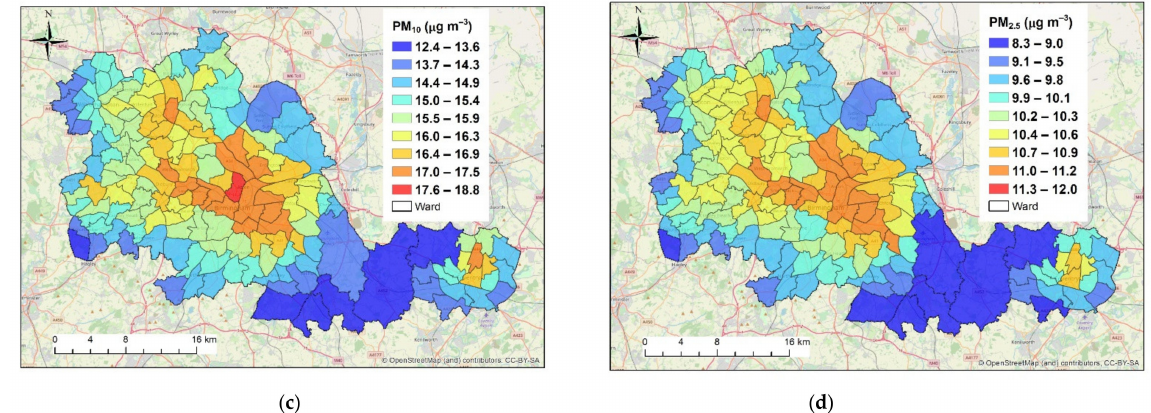
Figure A3. Projected annual air quality maps for ( a ) NO x (in µ g m − 3 ), ( b ) O 3 (in µ g m − 3 ), ( c ) PM 10 (in µ g m − 3 ) and ( d ) PM 2.5 (in µ g m − 3 ) in the ward